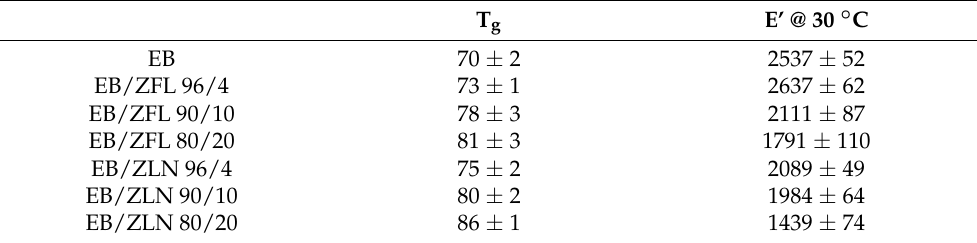
Table 1. T g and storage modulus at 30 °C of EB and its composites.